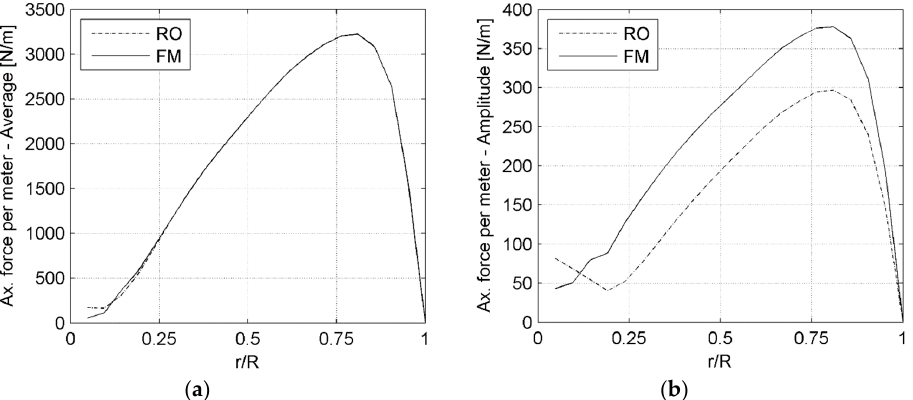
Figure 8. Axial force per meter of blade as a function of the span: ( a ) average value and ( b ) peak-to-peak amplitude of the oscillation.